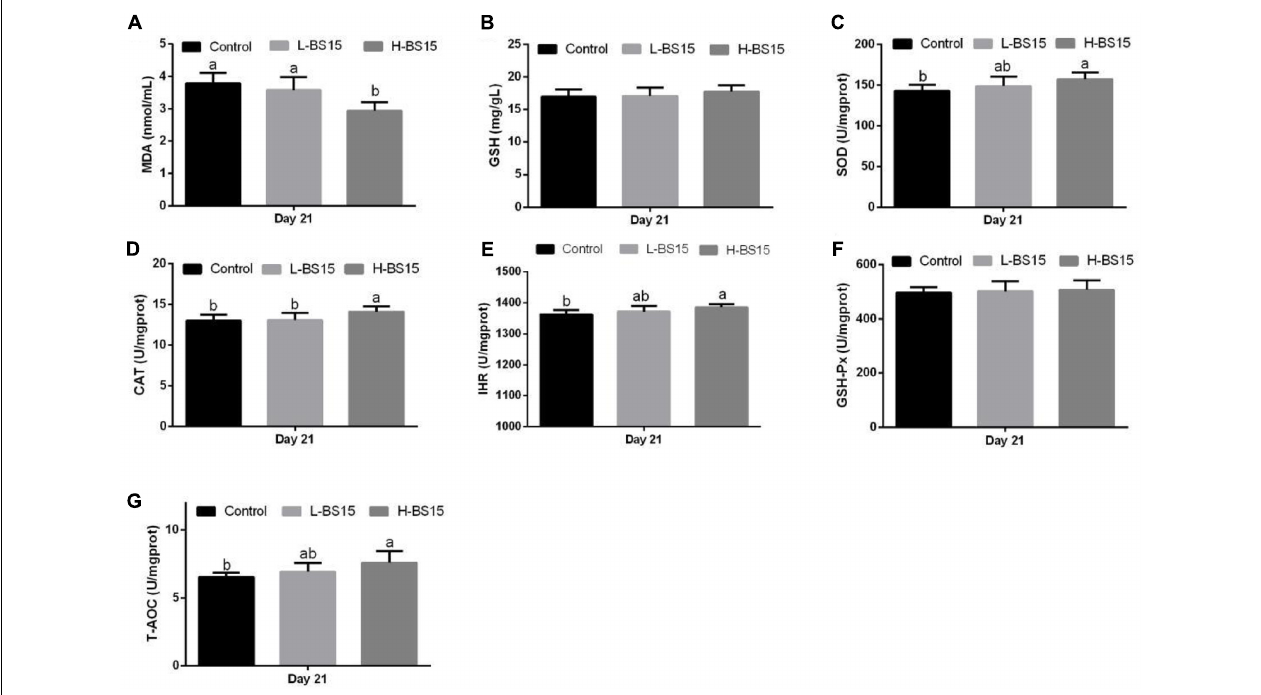
FIGURE 1 | Changes of MDA (A) , GSH (B) , SOD (C) , CAT (D) , IHR (E) , GSH-Px (F) , and T-AOC (G) in the serum at days 21 in Experiment 1. Bars with different letters are significantly different on the basis of Duncan’s multiple range tests ( P < 0.05). Data are presented as mean ± standard deviation (six replicates of one chick per cage). T-AOC, total antioxidation capacity; CAT, catalase; SOD, superoxide dismutase; GSH-Px, glutathione peroxidase; IHR, inhibiting hydroxy radical; MDA, malondialdehyde; GSH,